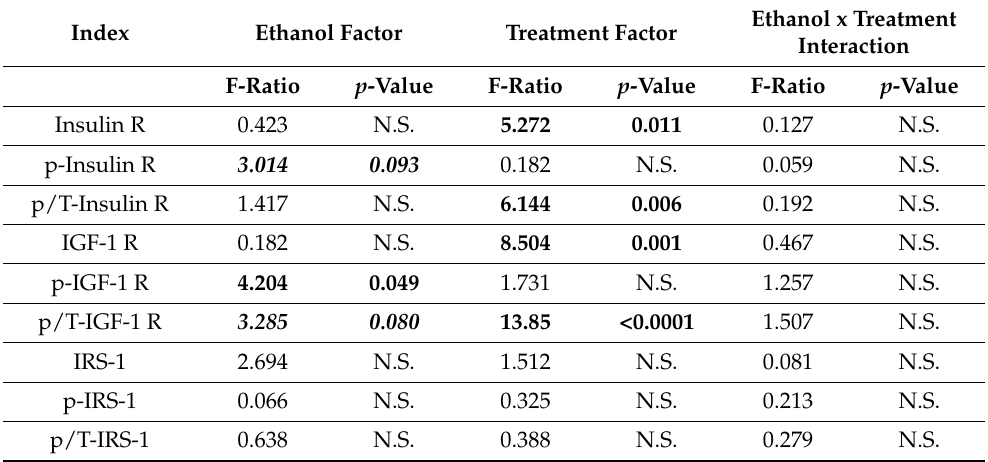
Table 2. Effects of In Vivo Ethanol Exposure and Ex Vivo Interventive Treatments on Insulin, IGF-1, and IRS-1 Signaling Mediators in Frontal Lobe Slice